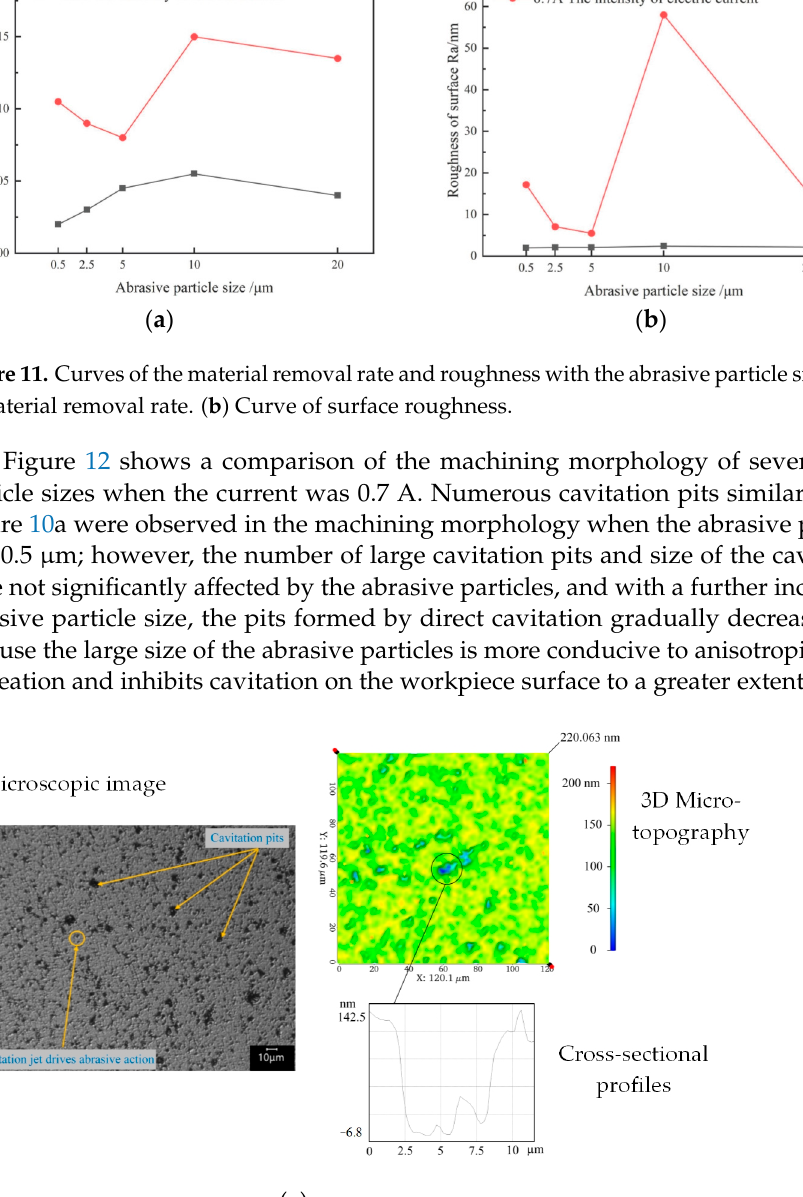
Figure 11. Curves of the material removal rate and roughness with the abrasive particle size. ( a ) Curve of material removal rate. ( b ) Curve of surface roughness.